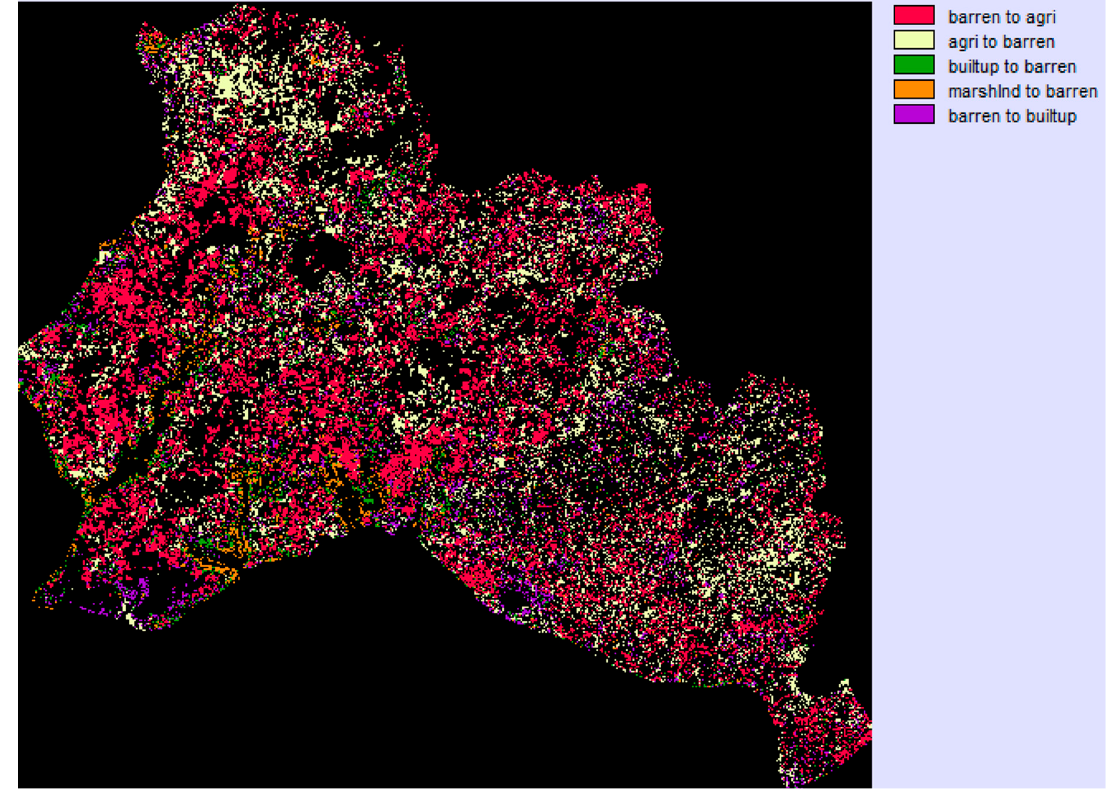
Figure 9. Principal changes among different categories in land use/land cover from year 2001 to 2011.